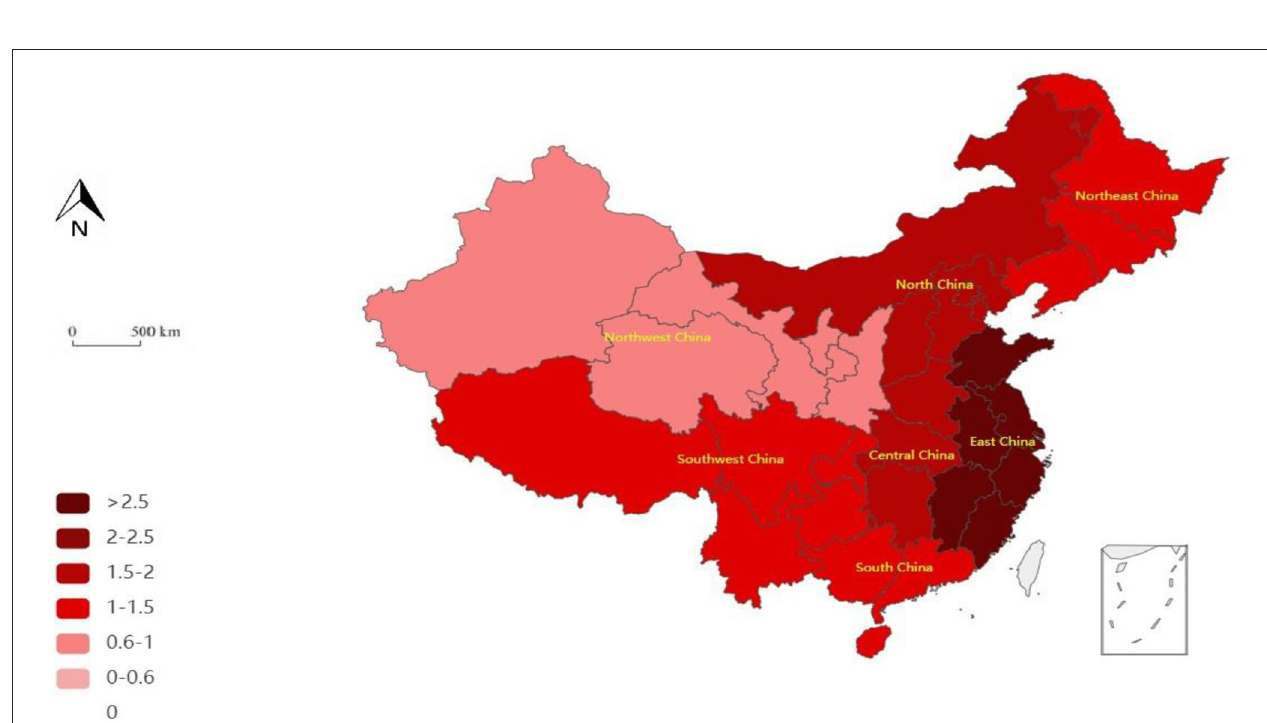
FIGURE 2 | Geographical pattern of the efficiency of medical PPP projects in the seven regions during China’s 13th 5-Year Plan period.